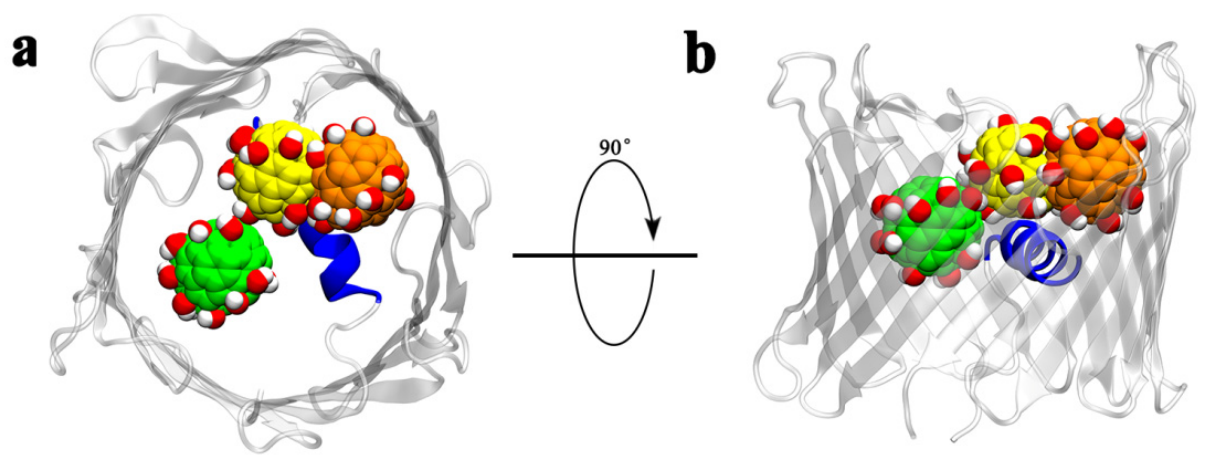
Figure 3. Superimposition of the three representative runs based on the backbone of hVDAC1 to show the relative positions of the Gd@C 82 (OH) 22 molecules that penetrated from OM. Top view from OM is shown in ( a ) and side view in ( b ).